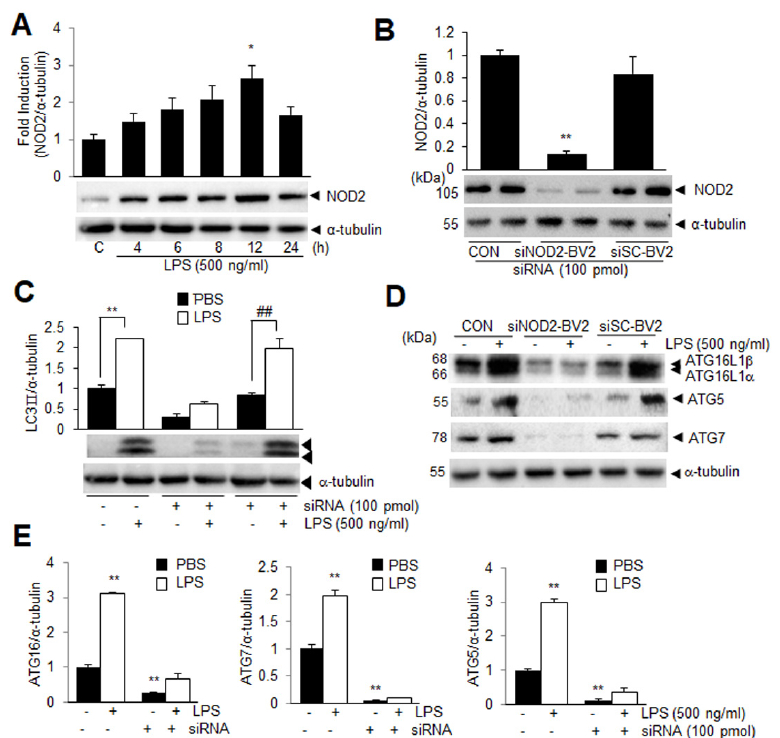
Figure 2. NOD2 deficiency suppresses LPS-induced autophagy in BV2 cells. ( A ) BV2 cells were treated with LPS (500 ng/mL) for 4, 6, 8, 12, and 24 h, and the level of NOD2 was examined using immunoblotting ( n = 3); ( B – E ) NOD2 siRNA or scrambled siRNA were transfected into BV2 cells (siNOD2-BV2 and siSC-BV2 cells, respectively); At 24 h after transfection, the basal NOD2 levels were examined using immunoblot analysis ( B ); At 24 h after transfection, the cells were treated with LPS (500 ng/mL), and the LC3 levels at 12 h post LPS treatment were examined ( C ); Levels of ATG5, ATG7, and ATG16 were examined in BV2, siNOD2-BV2, and siSC-BV2 cells at 12 h after LPS treatment using immunoblotting ( D , E ). Representative immunoblots are presented and quantification results are presented as the means ± SEM. * p < 0.05, ** p < 0.01 vs. PBS-treated control cells, and ## p < 0.01 between indicated groups using one–way ANOVA with Student–Newman–Keuls